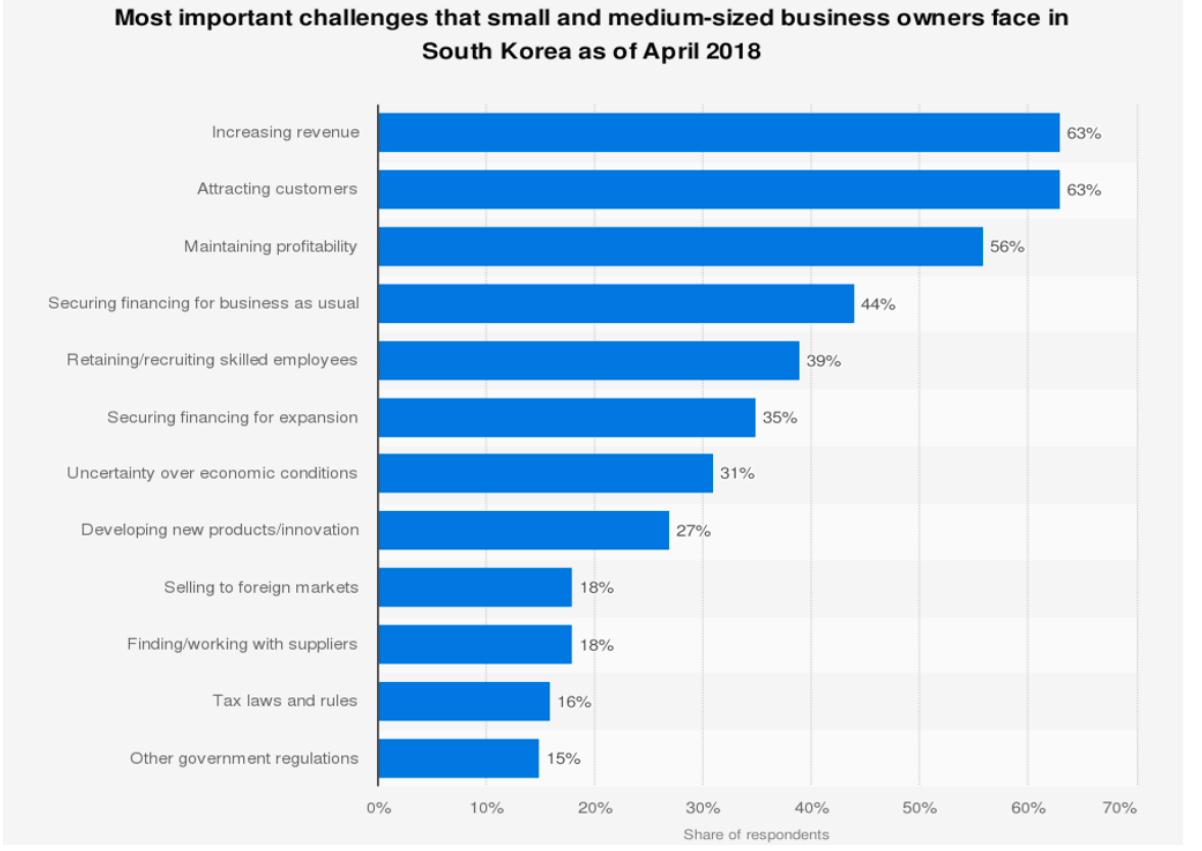
Figure 2. Most important challenges that small and medium business owners face in ROK (South Korea) as of April 2018 ( Source: Future of Business Survey; OECD; World Bank; Facebook; FactWorks ) [4].